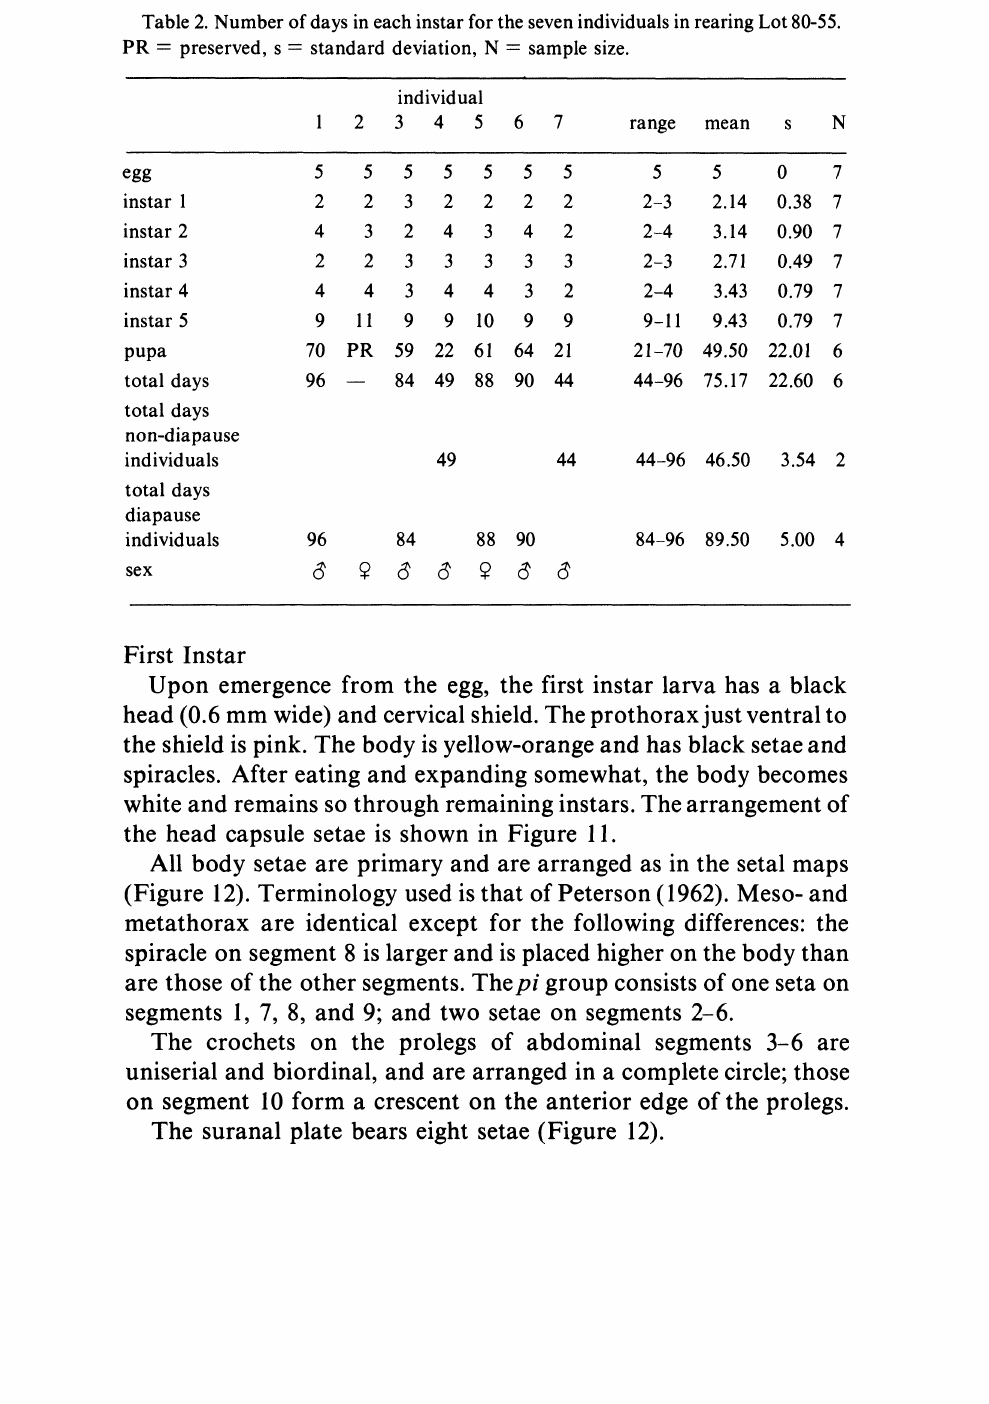
Psyche [Vol. 87 Table 2. Number of days in each instar for the seven individuals in rearing Lot 80-55. PR preserved, standard deviation, N sample size. individual